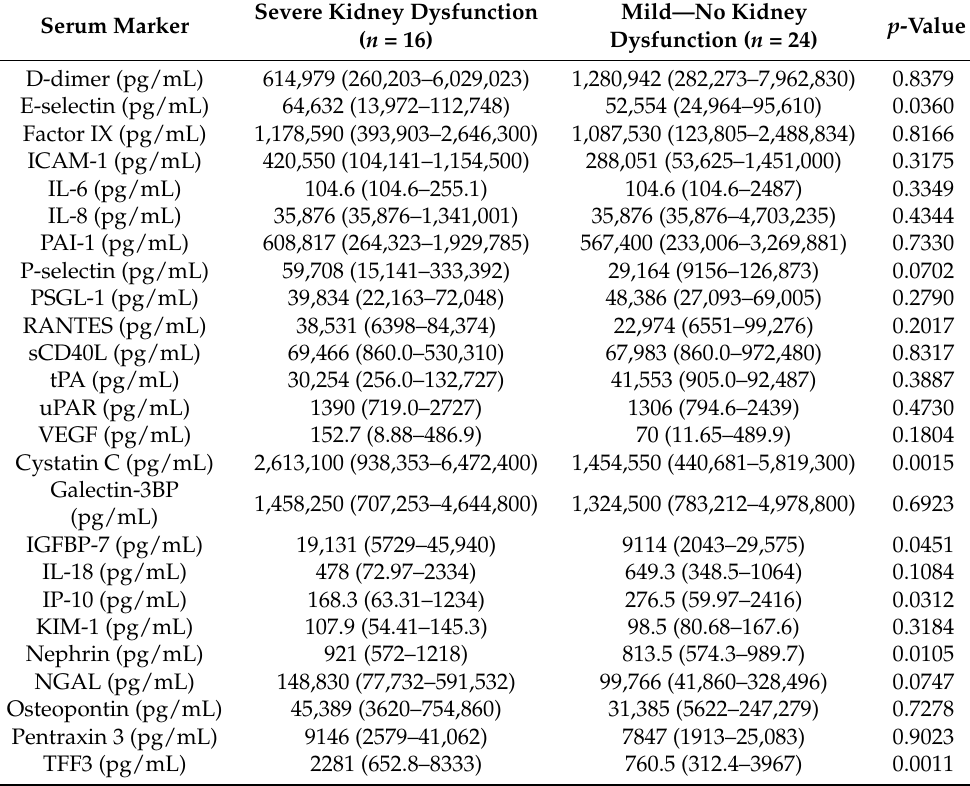
Table 4. Overview of serum marker levels in PUUV patients. Patients were considered to display severe kidney dysfunction when eGFR-values were <30 m/min/1.73 m 2 . Statistical significance was calculated by the Mann–Whitney U test; p -values < 0.05 were considered statistically significant. Median (range). Abbreviations: ICAM-1, intercellular adhesion molecule 1; IL-6, interleukin-6; IL-8, interleukin-8; PAI-1, plasminogen activator inhibitor-1; PSGL-1, P-selectin glycoprotein ligand-1; sCD40L, soluble CD40 ligand; tPA, tissue plasminogen activator; uPAR, urokinase plasminogen activator surface receptor; VEGF, vascular endothelial growth factor; Galectin-3BP, galectin-3 binding protein; IGFBP-7, insulin-like growth factor-binding protein 7; IL-18, interleukin-18; IP-10, interferon gamma-induced protein 10; KIM-1, kidney injury molecule-1; NGAL, neutrophil gelatinase-associated lipocalin; TFF3, trefoil factor